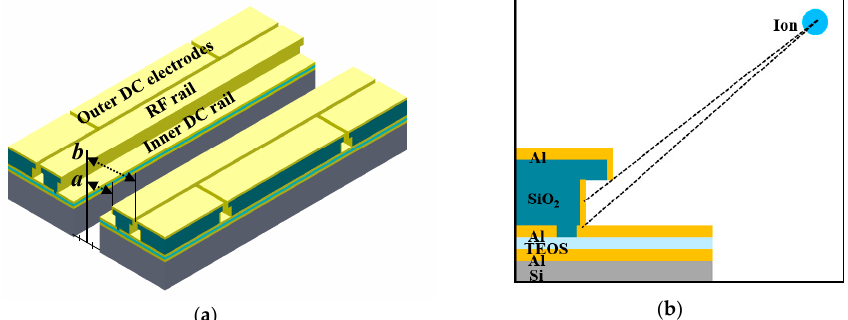
Figure 7. ( a ) Three-dimensional schematic of the surface ion-trap structures assumed in the case study and ( b ) a cross-section schematic of the surface ion trap under consideration. The structure is designed with metalized sidewalls to shield the trapped ions from the inevitable charges built up on the dielectric sidewalls.